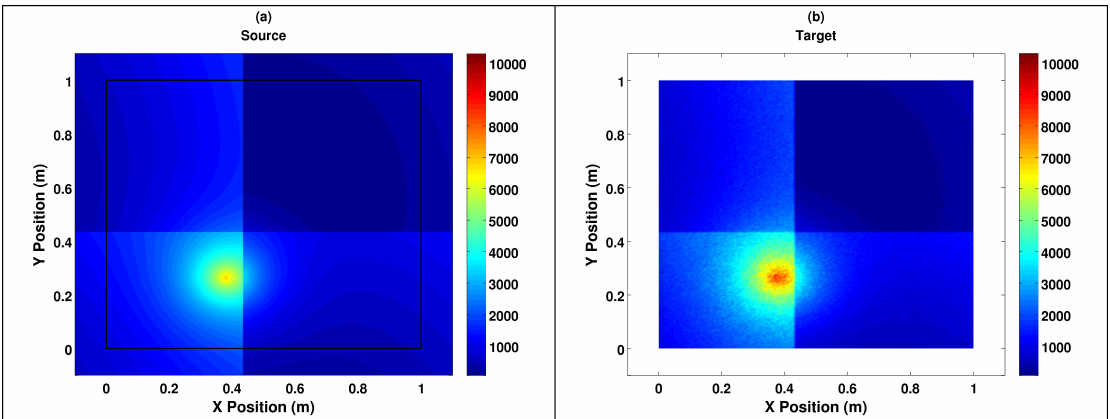
Figure 5. Comparison of the Pressures of one time step, both Source and Target , for oo = 100 . The color-bar represents the pressure